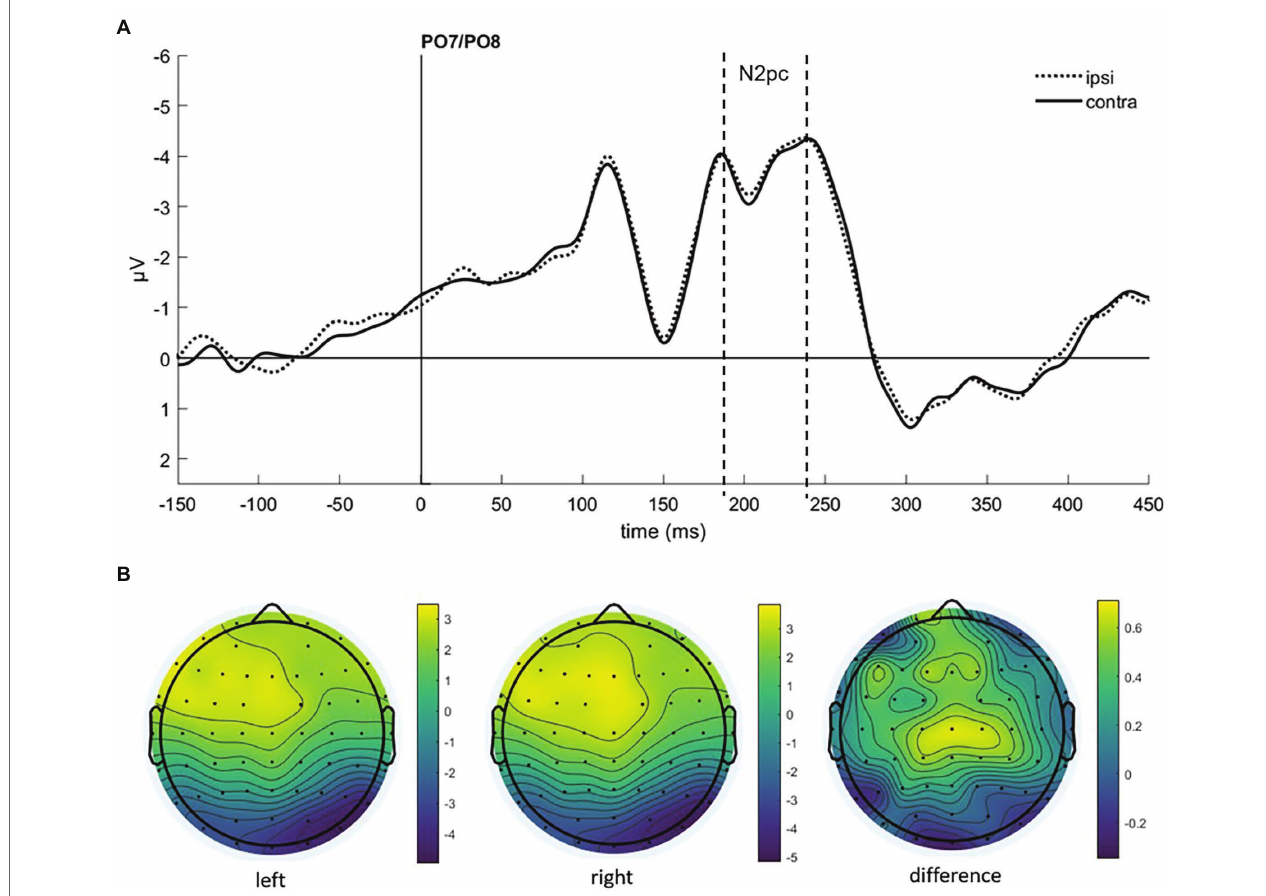
FIGURE 3 | (A) Event-related potentials (ERPs) in Experiment 1 after cue onset collapsed over experimental conditions. Activity contralateral to negative emotional face cues is represented by a solid line, ipsilateral by a dotted line. (B) Scalp topographies for left/right cue presentation and the difference (in μ V) averaged over 190–240 ms after cue onset